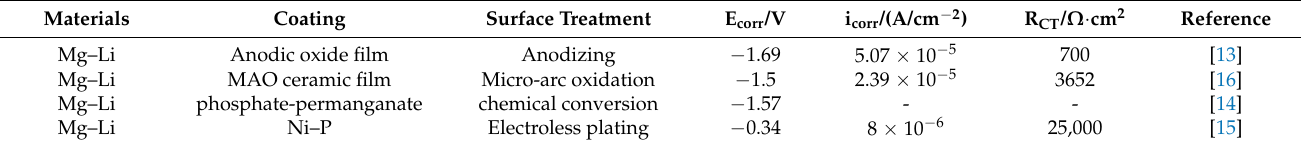
Table 1. The comparison about the corrosion resistance of the surface protection technologies. Materials